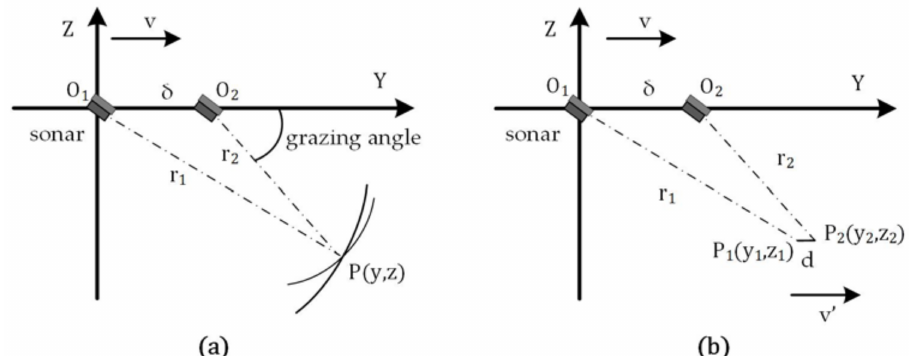
Figure 10. Diagram of the target and sonar in different states. ( a ) The target is stable while the sonar moves; ( b ) the target and the sonar move simultaneously.